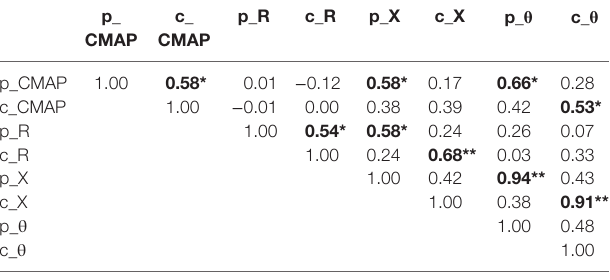
TaBle 1 | Pearson correlation coefficients between electrical impedance myography and compound muscle action potential